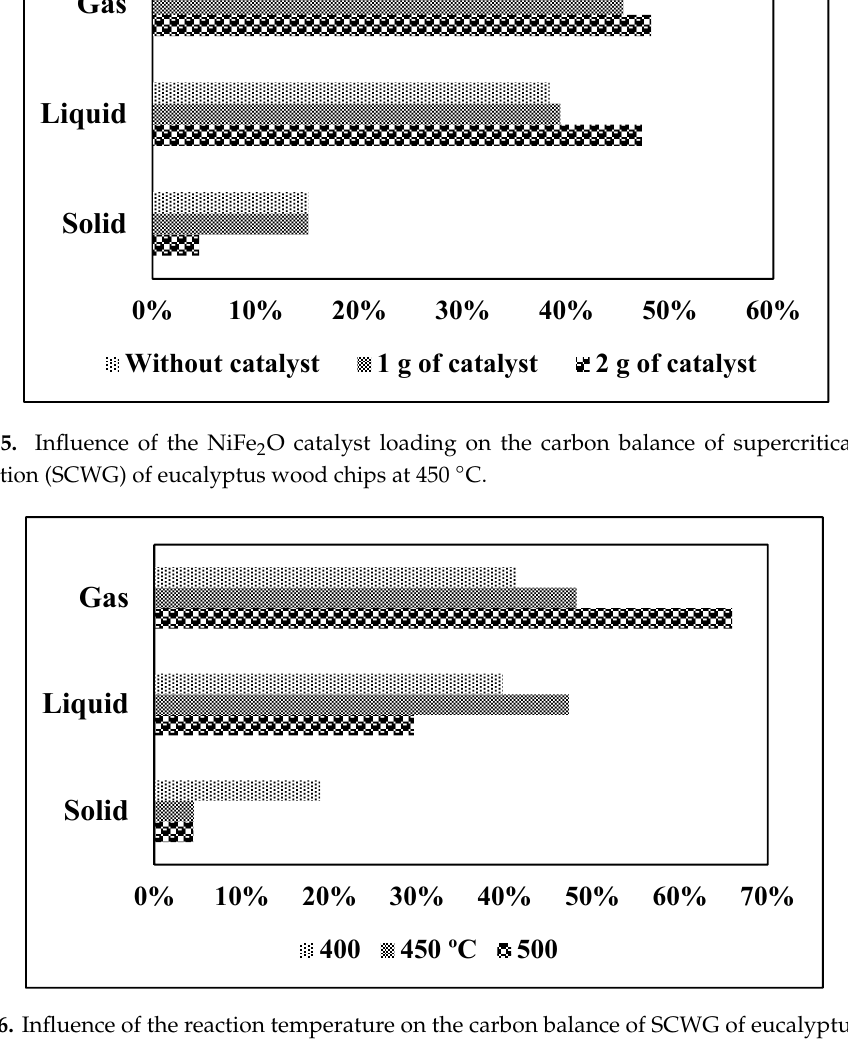
Figure 6. Influence of the reaction temperature on the carbon balance of SCWG of eucalyptus wood chips at 400, 450, and 500 ◦ C, using 2 g of NiFe 2 O 4 catalyst and a reaction time of 60 min. Table 2. Composition of the gaseous product.